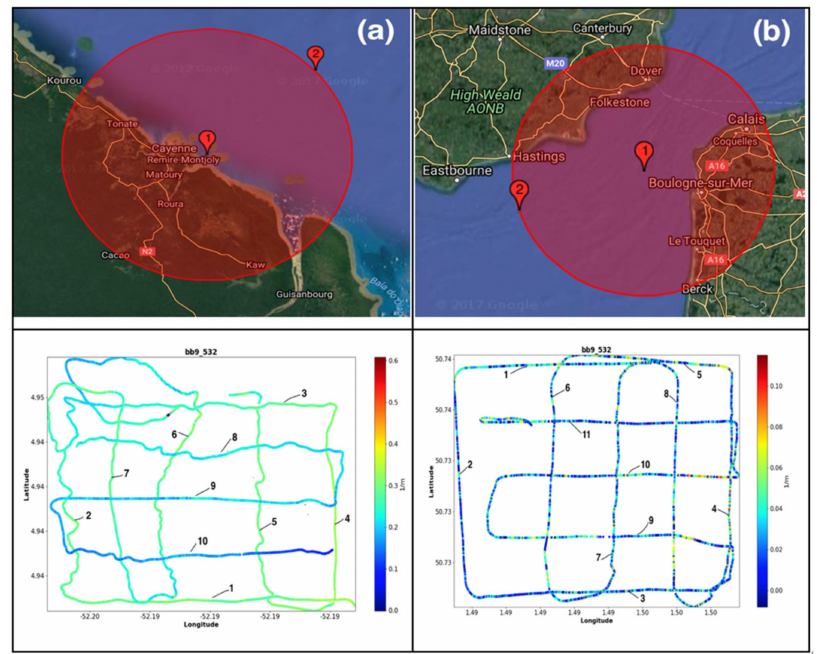
Figure 5. Examples of in-flow measurements of the back-scattering coefficients in French Guyana ( a ) and the Eastern English Channel ( b ).